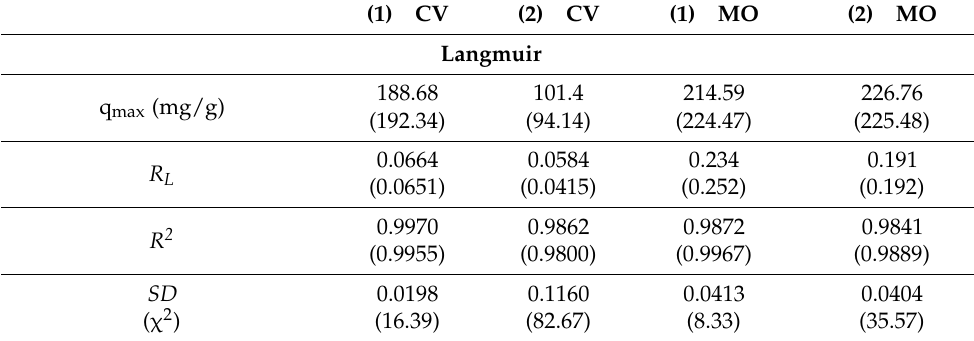
Figure 10. Equilibrium adsorption studies ( a ) Effect of initial concentration and (b ) Linear fit to Langmuir model for the adsorption of CV and MO dyes by adsorbents (1) and (2) at 25 ◦ C. For 25, 50, 100, 150, 200, 250, 300, 350 mg/L dye initial concentration. Adsorbent mass is 0.01 g and the volume of solution is 10 mL, agitation time 24 h. Table 2. Langmuir and Freundlich isotherm obtained using linear and (nonlinear equations) at 25 ◦ C, for the adsorption of CV and MO dyes for nanocomposites (1) or (2). The values in brackets are for the results of nonliear model